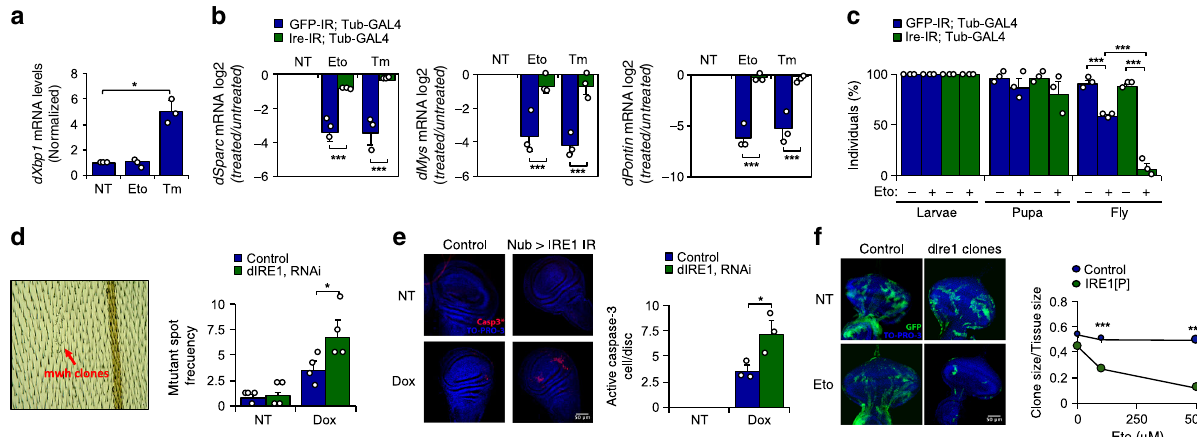
Fig. 5 IRE1 α expression confers protection against genotoxic stress in fl y models. a D. melanogaster larvae were fed with 100 μ M etoposide (Eto) or 50 μ g/ml tunicamycin (Tm) for 4 h and then dXbp1 s mRNA evaluated by real-time PCR and normalized to the expression levels of dRpl32 gene ( n =